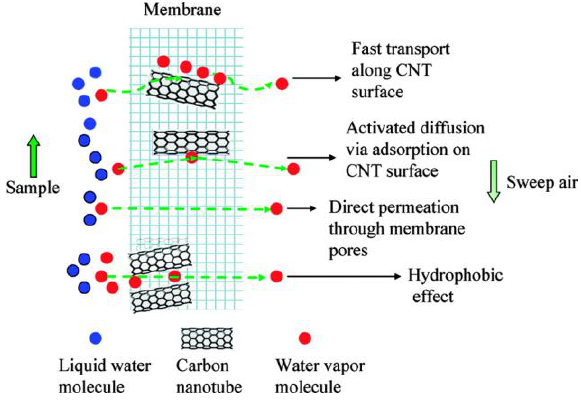
Figure 10. Mechanism of MD of CNTs-PVDF membranes [65].